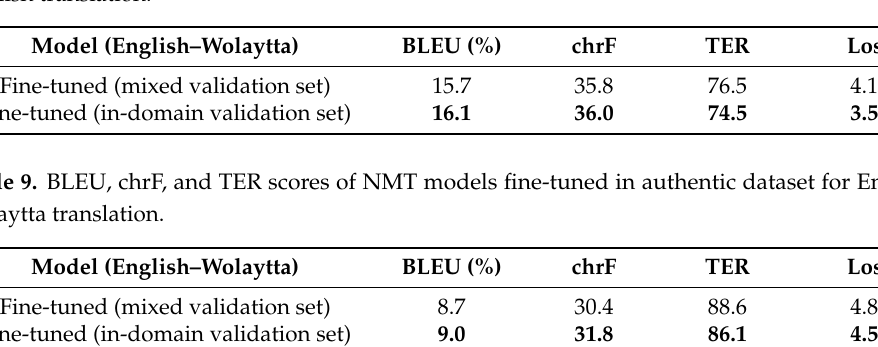
Table 8. BLEU, chrF, and TER scores of NMT models fine-tuned on the authentic dataset for Wolaytta– English translation.